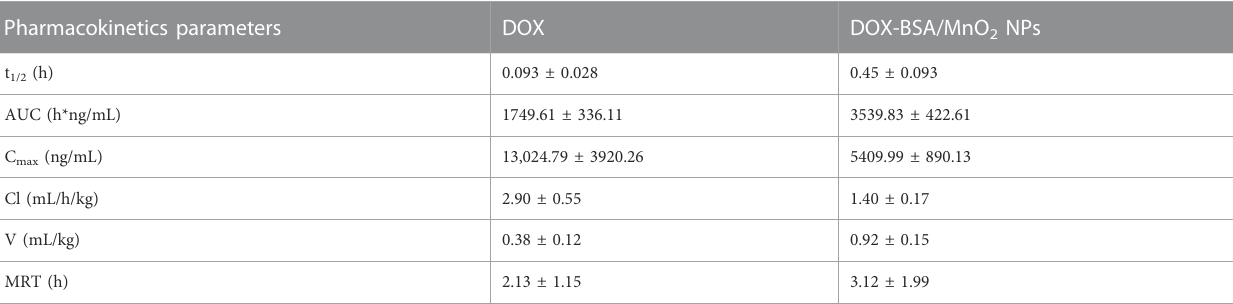
TABLE 1 Pharmacokinetic metrics of DOX solution besides DOX-BSA/MnO 2 NPs after a single IV in rats, n = 6. Pharmacokinetics